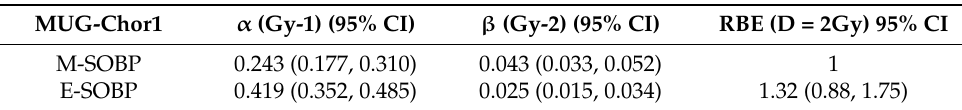
Table 2. Mug-Chor1 LQ fit and RBE (D E = 2